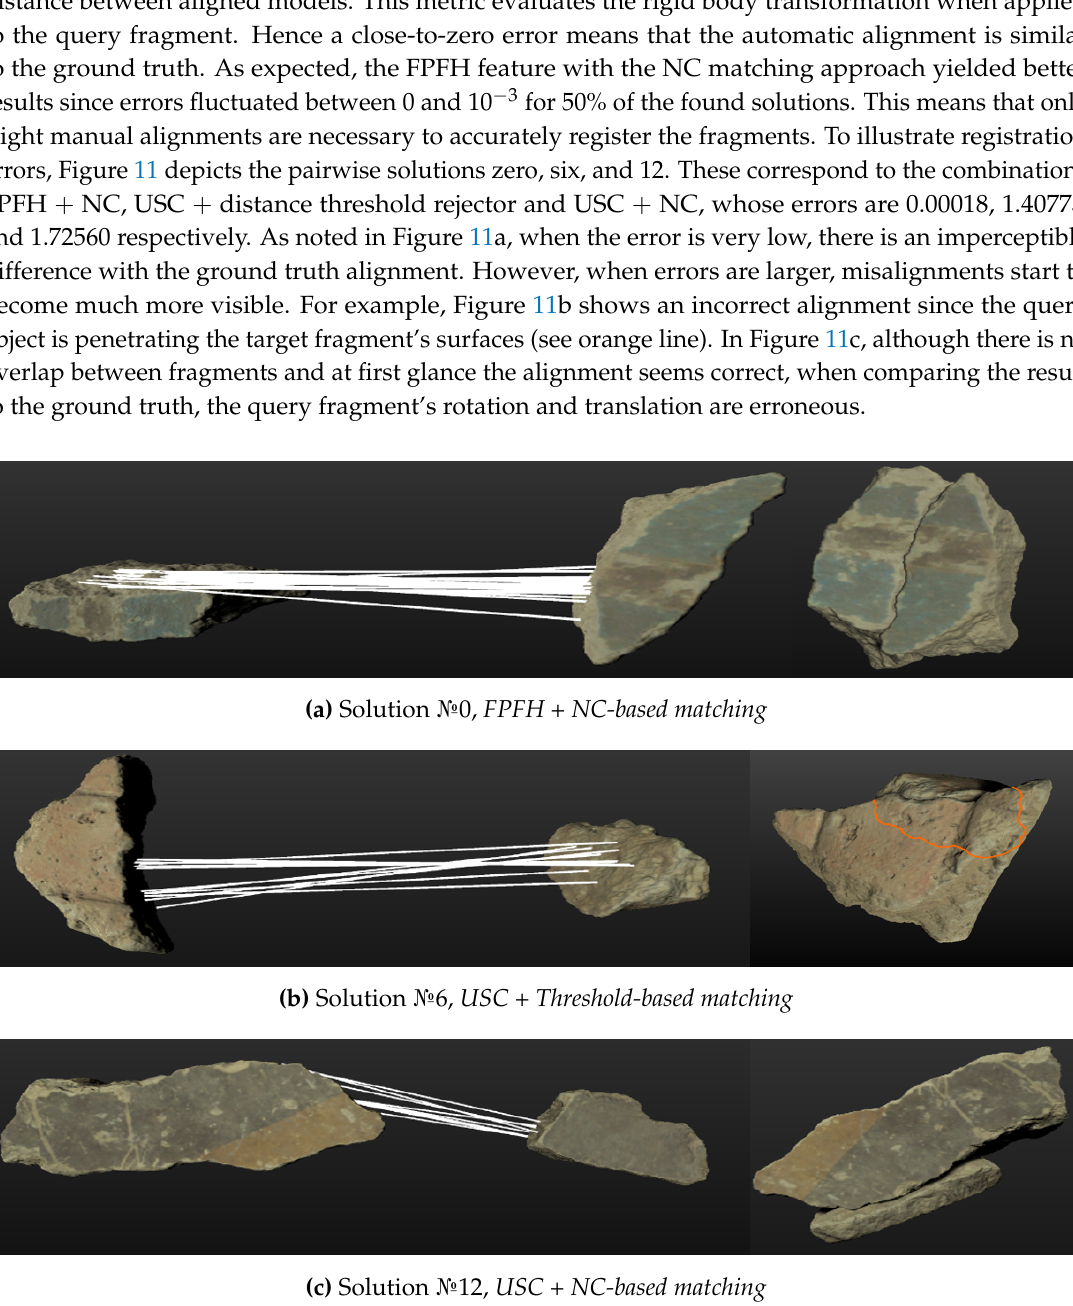
Figure 11. Examples of automatic matching results. On the left side, the computed correspondence points are visualized though matching lines. On the right side, the estimated rigid body transformation.